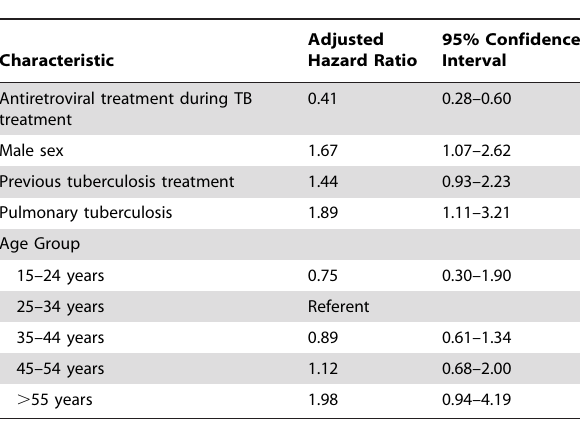
Table 5. Multivariate analysis of risk factors for mortality during TB treatment among HIV-infected TB patients, Andhra Pradesh 2007 (n=713).